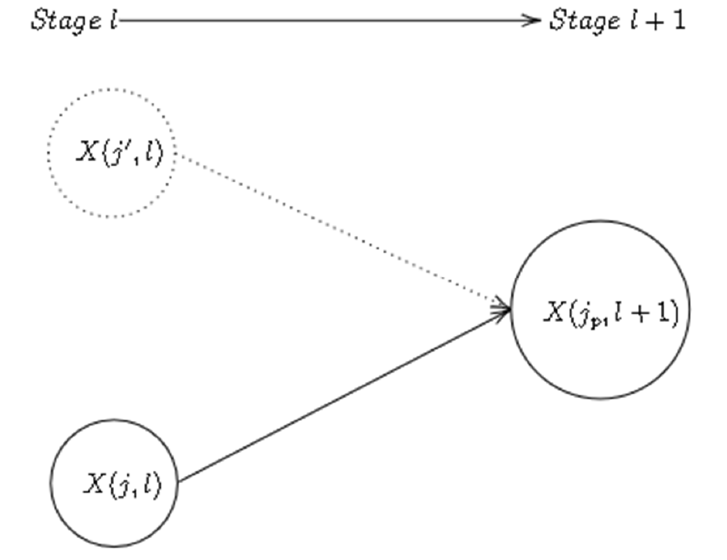
Fig. 2. Schematics of dominance rule and transitional state in the graph